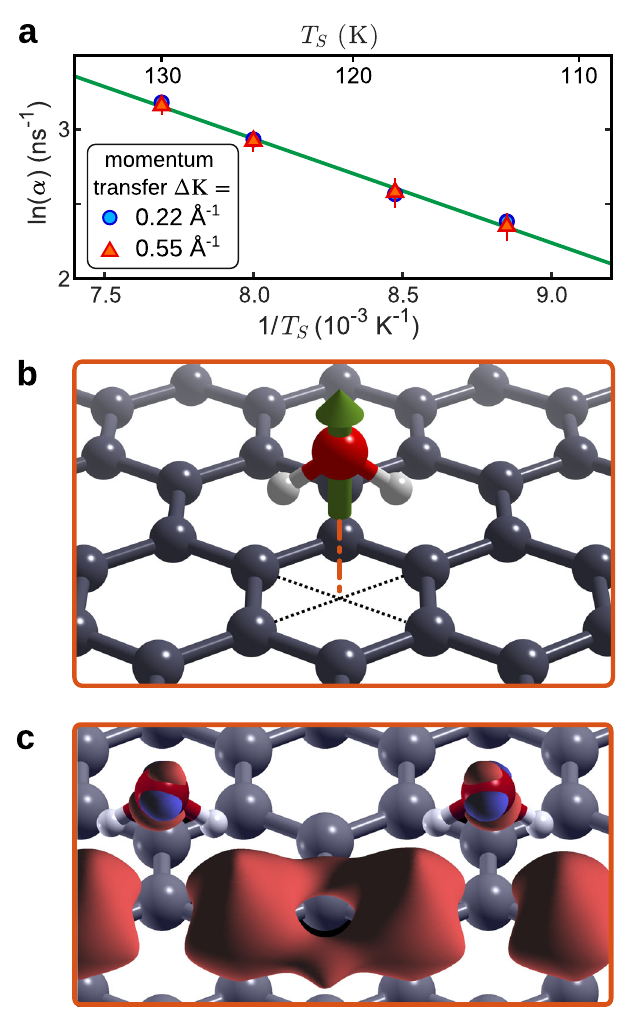
Fig. 4 Temperature dependence and theoretical results for water adsorbed on graphene. a The temperature dependence of α (error bars correspond to 1 σ con fi dence bounds) can be used to determine the activation energy for diffusion of water on graphene based on the slope of a linear fi t (green solid line). A constant surface coverage of 0.07 ML, corresponding to a re fl ectivity attenuation factor of 4, was maintained at all temperatures by adjusting the H 2 O over-pressure applied. b Adsorption geometry of water (H/O atoms as white/red spheres) on graphene (grey spheres) with the green arrow illustrating the direction of the net dipole of the water molecule. c Charge density difference for two water molecules adsorbed on graphene (red/blue isosurfaces correspond to ±0.0025e/ Å 3 ) illustrating the dipole moment. The dipole moment of a water monomer on graphene is 6.4 × 10 − 30 Cm = 1.9 D, which is slightly larger than for an isolated water molecule.